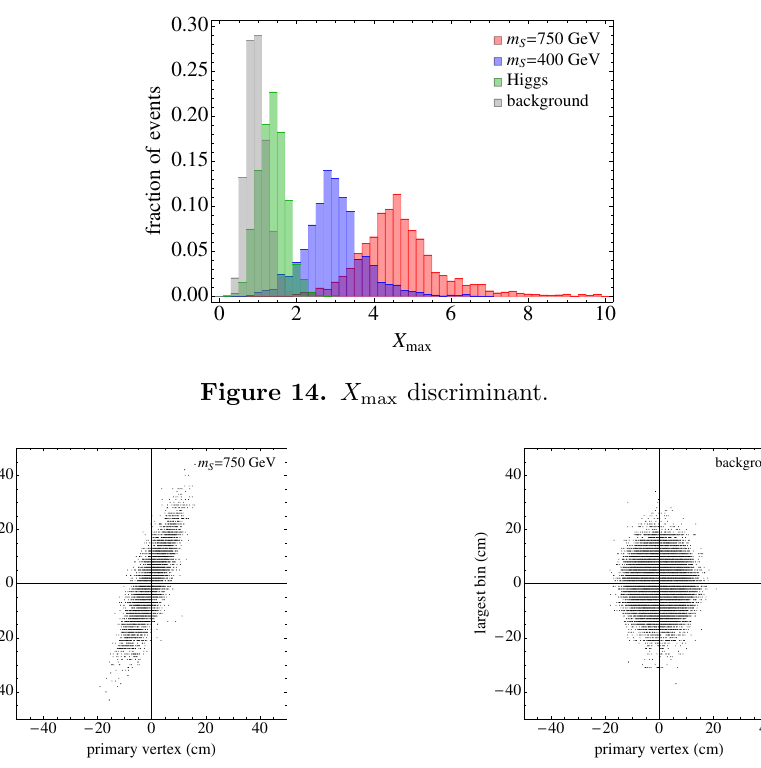
Figure 15. Location of the truth-level primary vertex vs the location of the bin the largest number of